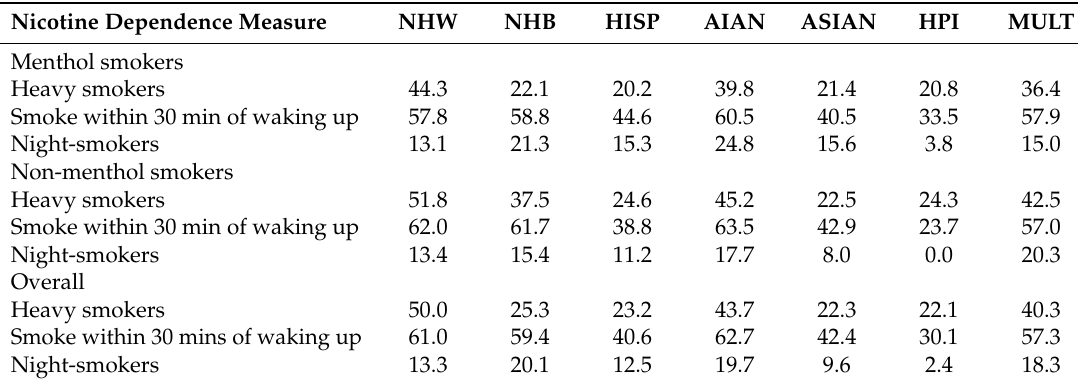
Table 3. Percentage of daily smokers with higher levels of nicotine dependence for each nicotine dependence measure, race/ethnicity and menthol/non-menthol smoking status. Nicotine Dependence